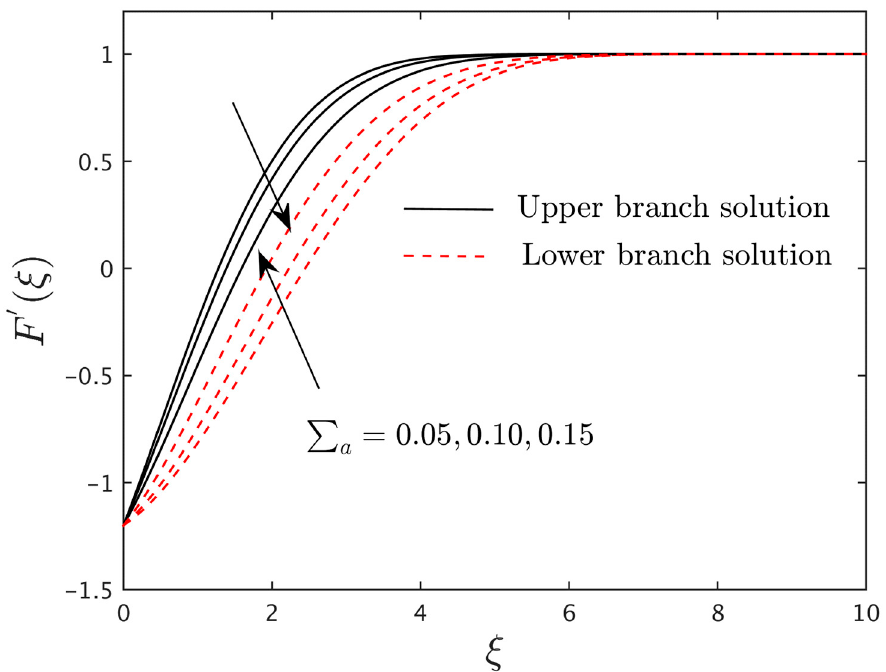
Figure 8. The velocity profiles F (cid:48) ( ξ ) for the numerous values of Σ a when Pr a = 1.0, Sc a = 10.0, Pr = 6.2, ϕ = 0.025, and γ s = 0.5.